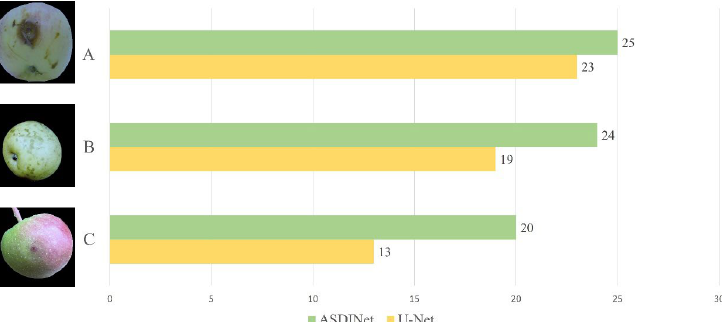
Figure 15. Detection results of three typical apple defects by the ASDINet and U-Net. Out of the three defects, A has a moderate size, B is relatively large but light in color, and C is very small.